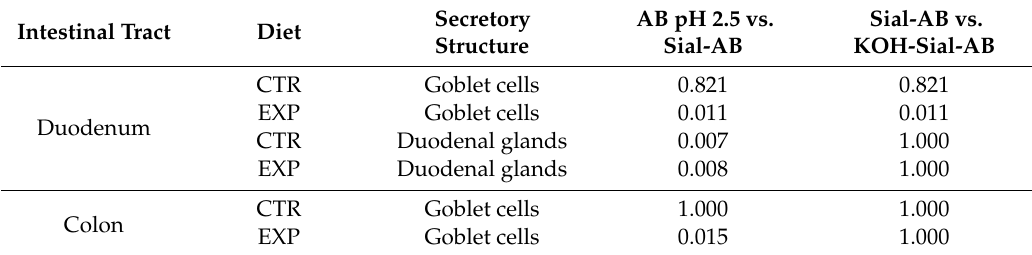
Table 4. Statistical significance values of di ff erences in location shift of reactivity ranks, obtained using Wilcoxon Mann–Whitney tests, between the sequential treatments AB pH 2.5 vs. Sial-AB, and Sial-AB vs. KOH-Sial-AB, inside each diet group (CTR and EXP) in duodenum and colon of pig. The significance threshold was set at p = 0.05.